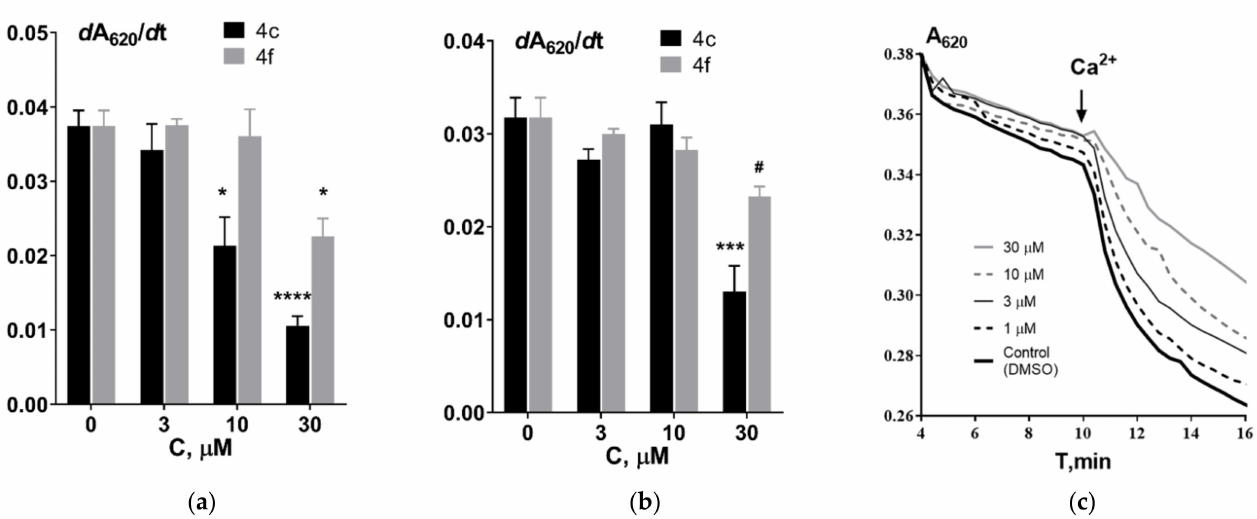
Figure 6. Effect of compounds 4c and 4f on the rate of Ca 2+ -induced mitochondrial swelling. ( a ) in the presence of the substrate of complex II and the inhibitor rotenone of complex I. ( b ) compared to mitochondria energized by glutamate and malate. ( c ) representative curve of 4c influence on the kinetics of mitochondrial swelling in the presence of the substrate of complex II and the inhibitor rotenone of complex I. The Ca 2+ concentration was 12.5 µ M. The significance of the differences was estimated by two-factor dispersion analysis ANOVA with Tukey’s post-hoc multiple comparison test (* p ≤ 0.05, *** p ≤ 0.001, **** p ≤ 0.0001, comparison with the control group) and Student’s t -test (# p ≤ 0.05, comparison with the control